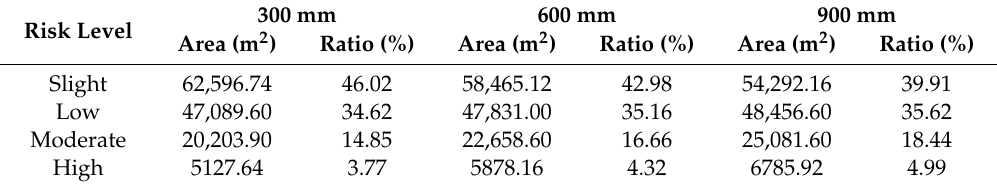
Table 6. Results of landslide risk obtained by the mixed tested model.